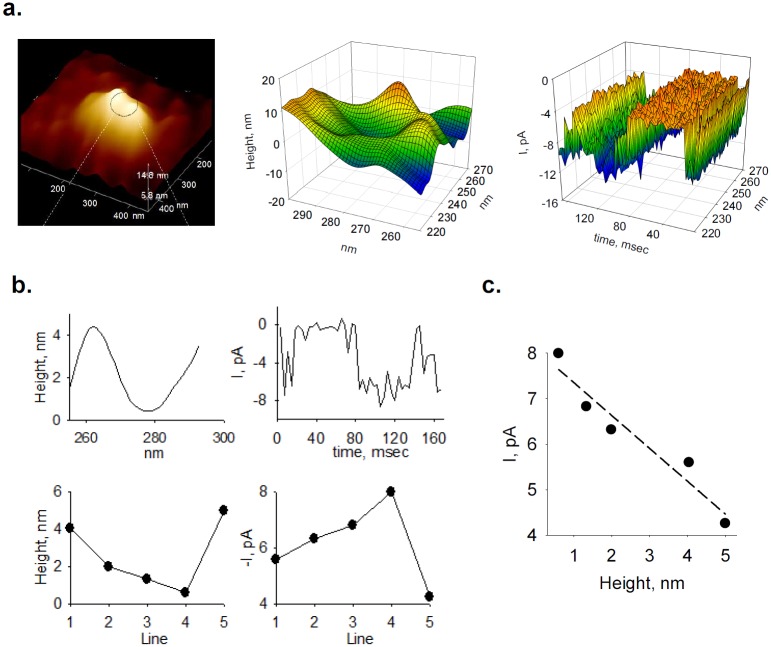
Temporal correlation between PC2 topological features and single channel currents.a. (Left) BLM scanned image of a single PC2 channel complex (400 x 400 nm). 3D reconstruction of the channel opening (Middle), and corresponding electrical recordings (Right) from single-line scans as shown in the 3D plot. b. Example of single height line of the channel complex (Top Left), and corresponding current amplitude obtained while scanning that line (Top Right). Bottom Panels show corresponding heights and single channel currents for five consecutive single line scans, with an average in-between-lines time of 0.016 msec. c. Both sets of experimental data showed an inverse linear correlation for the same channel complex. (Data representative of n = 3).